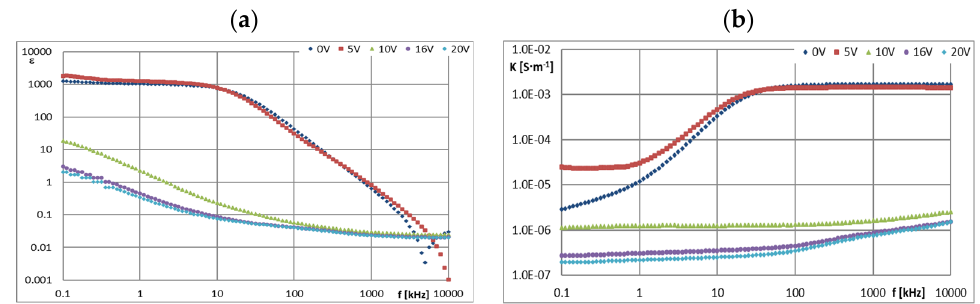
Figure 5. Characteristics: ( a ) ε = f( f ) and ( b ) κ = f( f ) for CJ001 at different values of U.